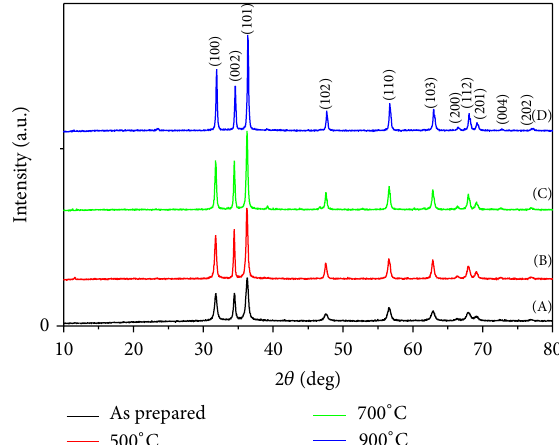
Figure 15: XRD patterns of nanotube ZnO after and before annealing at different temperatures: (A) as prepared, (B) 500 ∘ C annealing, (C) 700 ∘ C annealing, and (D) 900 ∘ C